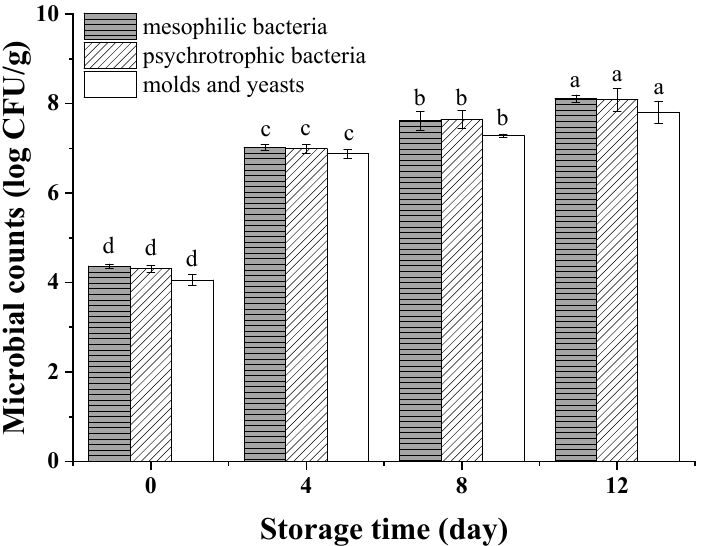
Figure 3. Mesophilic bacteria, psychrotrophic bacteria and molds and yeasts of vacuum-packaged peeled potatoes during storage. The different letters in mesophilic, psychrophilic bacteria and molds and yeasts indicate significant differences ( p < 0.05).